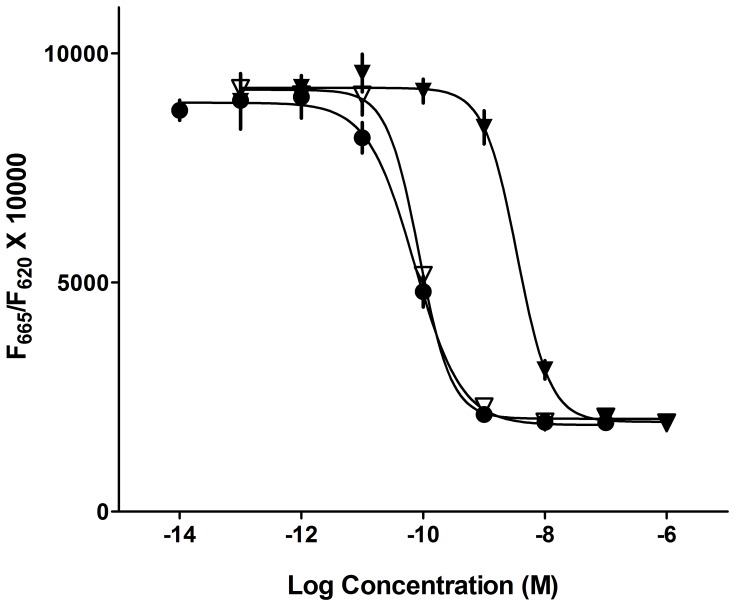
Functional activity at the GLP-1 receptor.GLP-1 (7–36) (▪), [Leu14]exenatide-ABD (▾) and [Leu14]exenatide-ABP (▿). GLP-1 (7–36) was used as a reference standard in the assay. The assay was run in quadruplicates and data are presented as mean ± SD. Abbreviations: Fluorescence (F).